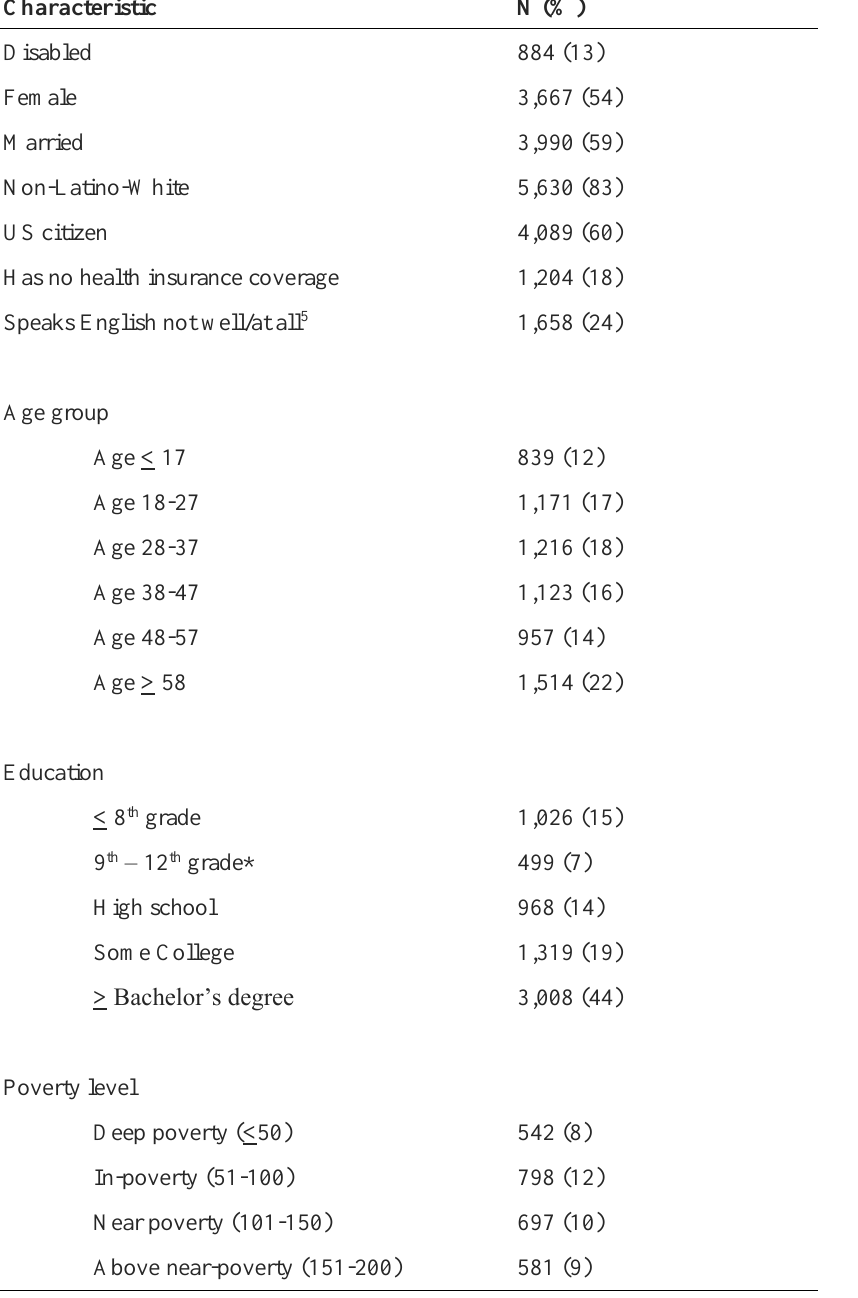
Table 1. Demographics of 6,820 Central Asians living within the US